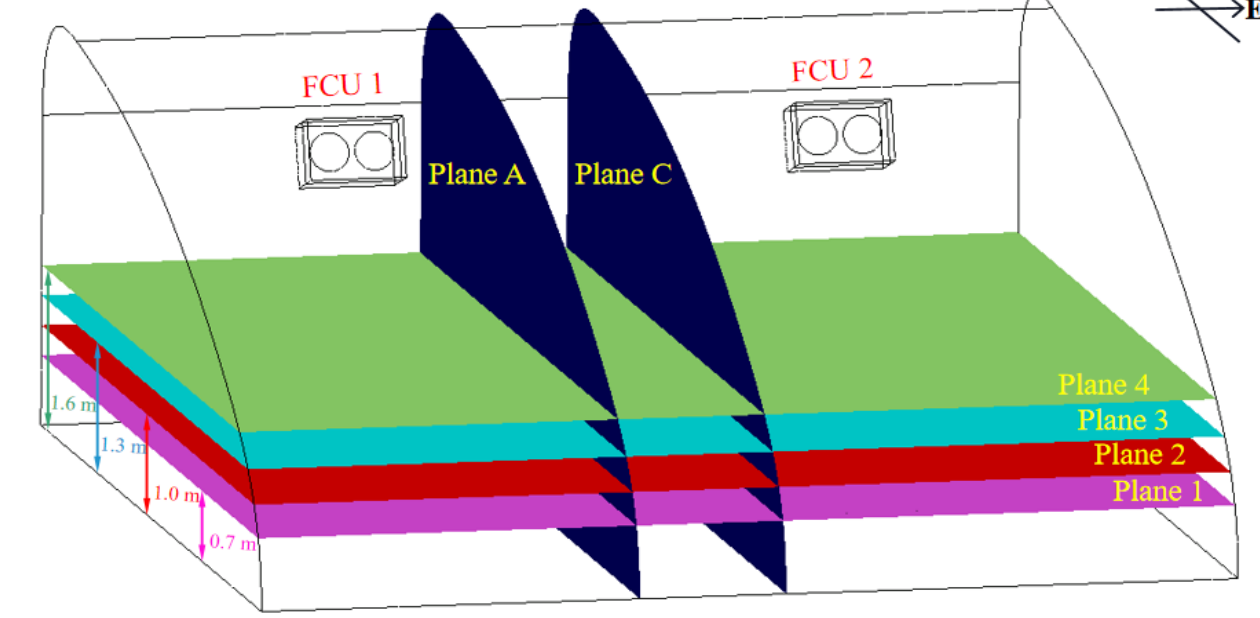
Figure 6. Layout of optimization target plane.